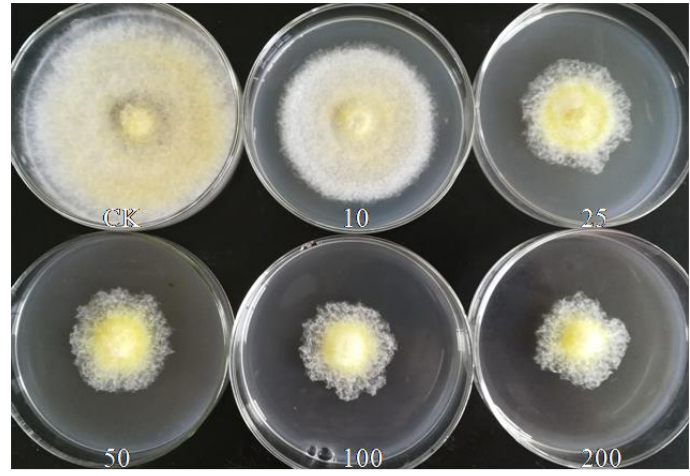
Figure 5. Colony growth inhibition of silver nanoparticles against V. mali.